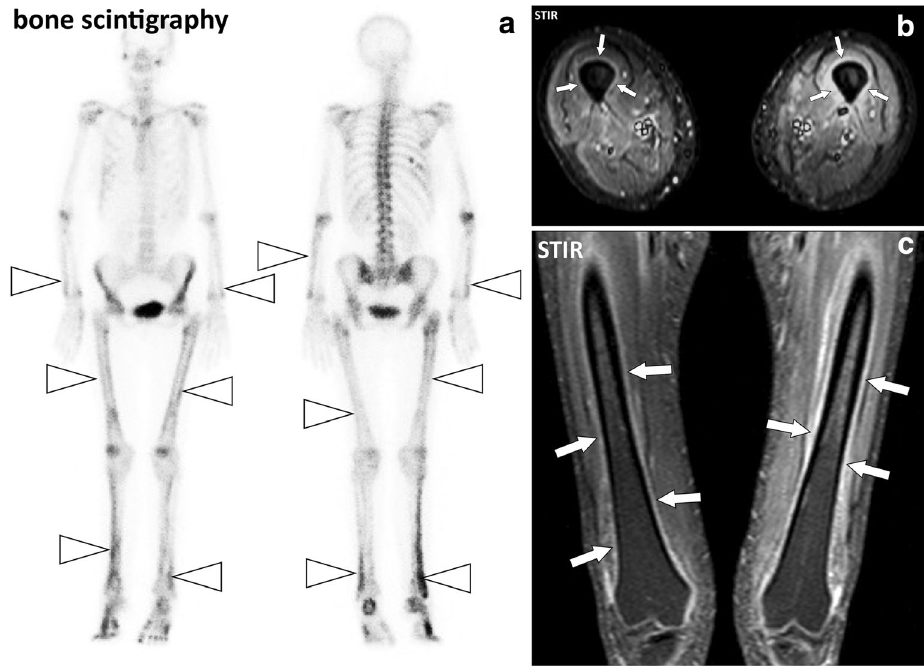
Fig. 17 a Anterior and posterior whole-body bone scintigraphy, ( b ) axial and ( c ) coronal STIR images of the thighs of a 55-year- old female with pulmonary neo- plasm and hypertrophic osteoarthropathy. Bone scintigra- phy demonstrates symmetric lin- ear increased uptake of tracer along the diaphysis and metaphysis of the long bones (ar- rowheads). MRI confirms perios- titis with thickening and fluid signal intensity of the periosteum of the left femur and to a lesser degree of the right femur (arrows)